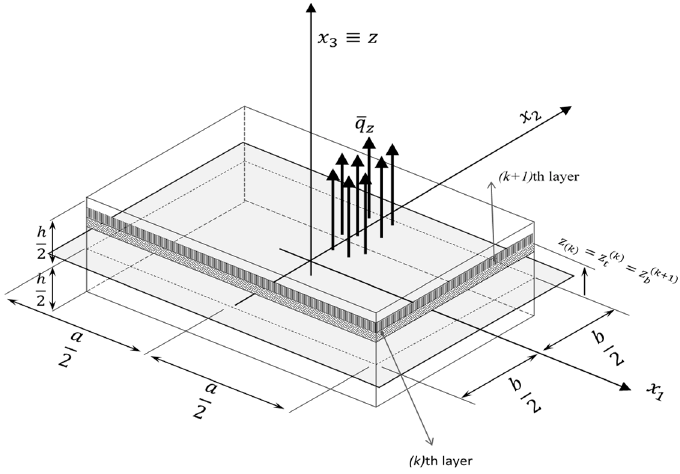
Figure 1. Multilayer plate: Geometry and reference frame.